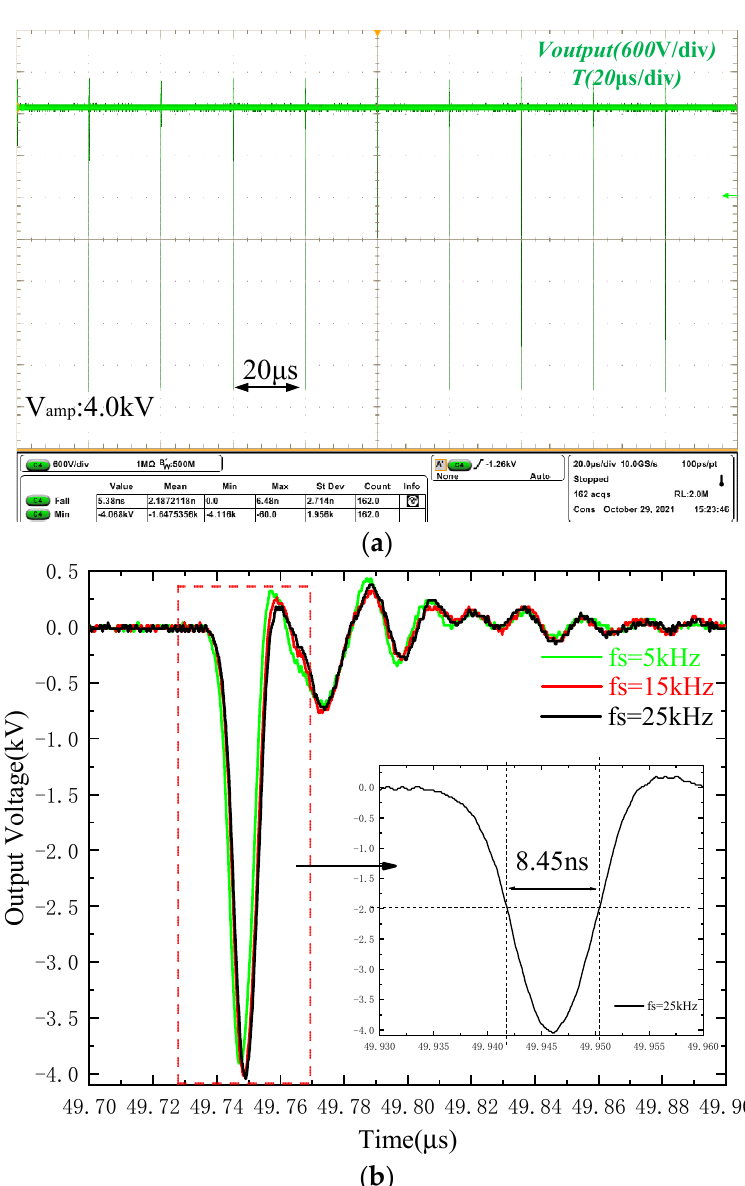
Figure 10. The voltage waveform of the load (circuit II): ( a ) discharge waveform with a repeatable frequency of 50 kHz; ( b ) enlarged view of load voltage in a different frequency.